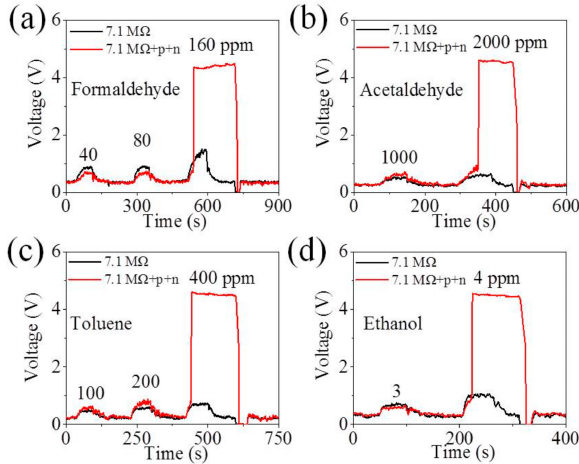
Figure 3. Output voltage of Mn-doped ZnO (MZO) to ( a ) formaldehyde from 40 to 160 ppm and ( b ) acetaldehyde from 1000 to 2000 ppm; ( c ) toluene from 100 to 400 ppm ( d ) ethanol from 3 to 4 ppm in the traditional circuit and the interlocking p+n FET circuit (R L is 7.1 M Ω ) under humidity of